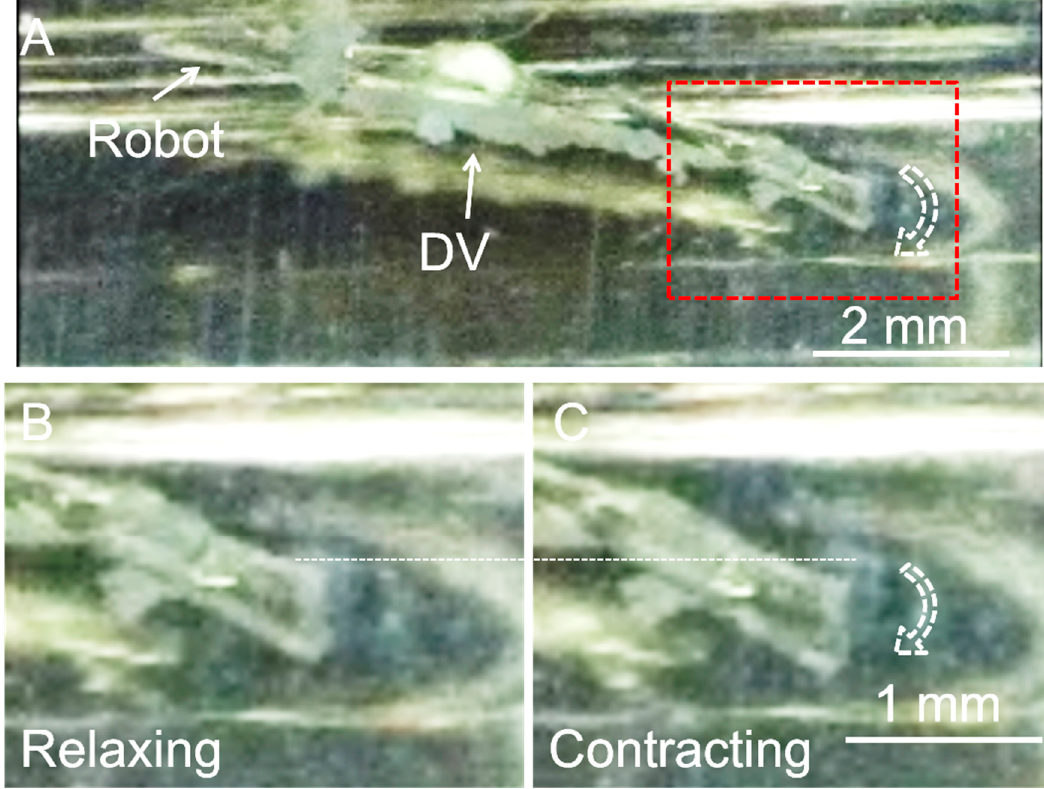
Figure 7. Motion of the swimming robot when it was released into a solution environment. ( A ) Image taken from the side direction of a video recording showing a bending motion of the tail fin. ( B ) Image of the swimming robot in a relaxed condition. ( C ) Image of the swimming robot in a contracted condition.